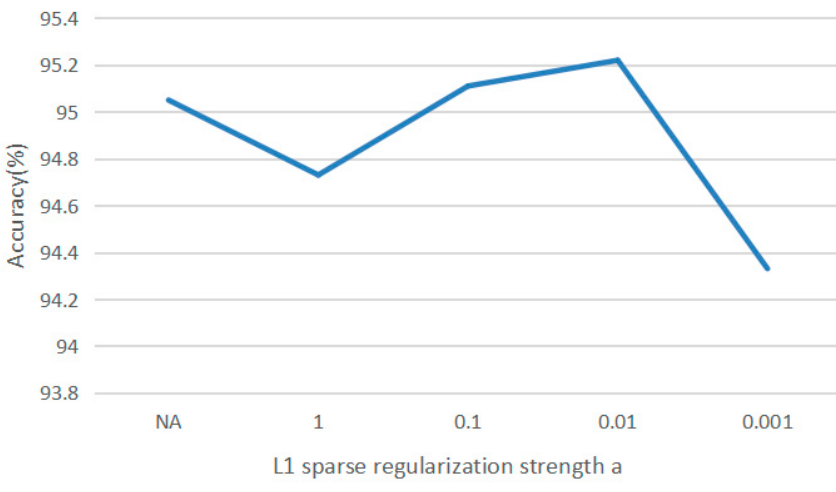
Figure 8. Comparison of different parameters of a.